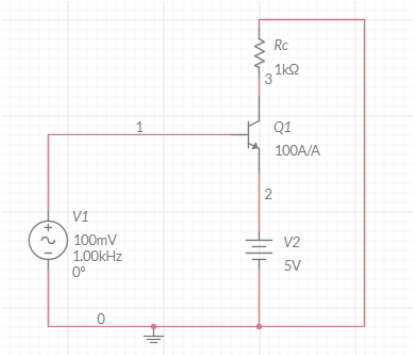
Figure 7. Initial testing driver circuit for TIP31C.